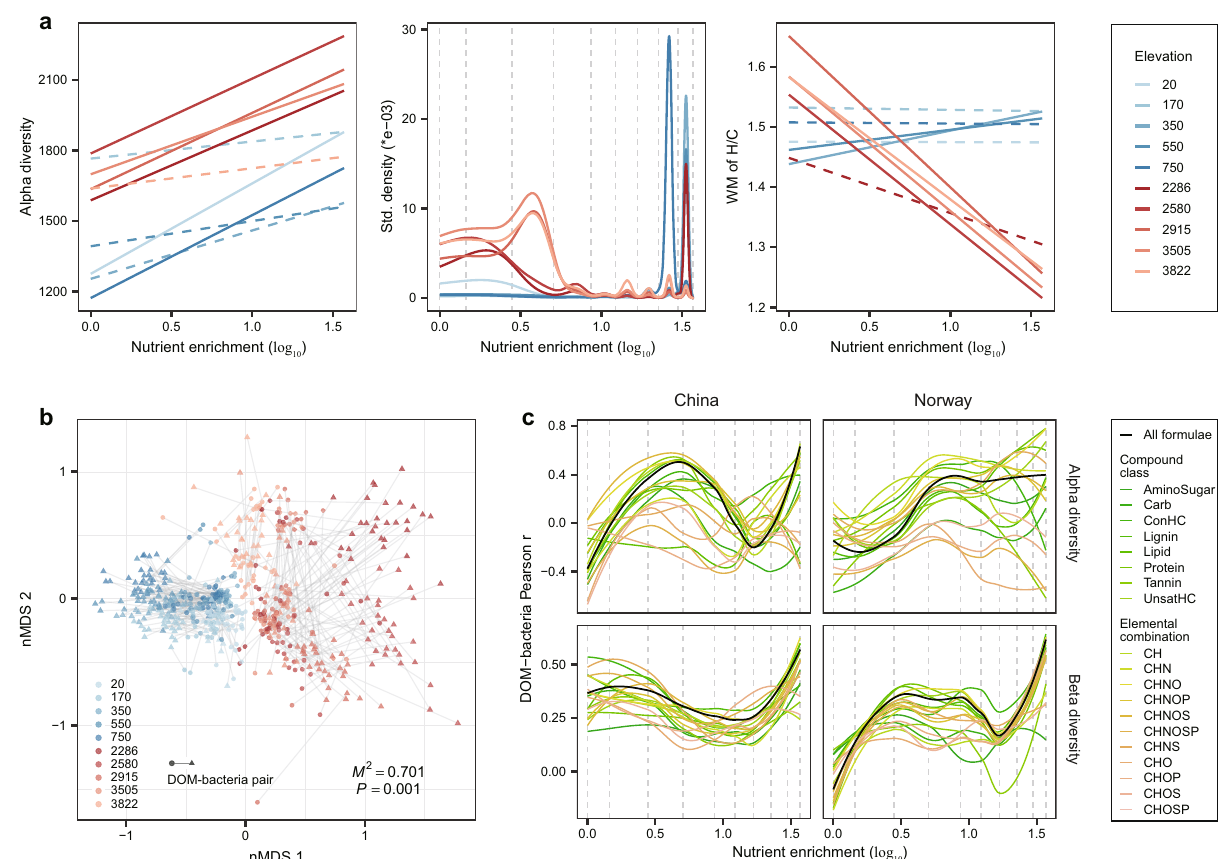
Fig. 3 DOM features and their bacterial associations at a compositional level. a The effects of nutrient enrichment on DOM alpha diversity (richness), composition and molecular traits (e.g., H/C ratio) for all formulae across different elevations in China (red lines, with lower elevations in more red colours) and Norway (blue lines, with higher elevations in more blue colours). We used nitrate addition to represent nutrient enrichment as the ratio between nitrate and phosphorus in the initial overlying water was constant. Molecular richness and weighted mean (WM) of H/C ratio were plotted against the nutrient gradient of nitrate, and their relationships are indicated by solid ( P ≤ 0.05) or dotted ( P > 0.05) lines estimated using linear models with one-sided F-statistics. For better visualization, we did not include the data points in Fig. 3a but showed detailed scatter plots and statistics in Fig. S3. To visualise the DOM compositional changes, we plotted the distribution of breakpoints of each molecule regarding its abundance occurring along the nutrient gradient with gradient forest analysis 30 . b The congruence between DOM and bacterial compositions across different elevations in China and Norway was examined using Procrustes analysis 32,33 . The NMDS plots the position of DOM and bacterial assemblages that have been optimized based on Procrustes analysis. Each line with circle and triangle ends connects to a single community of DOM and bacteria, respectively, and is coloured by elevation in either China (red) or Norway (blue). The fi t of overall Procrustes transformation is reported as the M 2 value, and the signi fi cance was examined using a permutation-based approach with 999 permutations and the two-sided statistically signi fi cant P value is shown. c The effects of nutrient enrichment on DOM-bacteria associations. The associations were quanti fi ed by the Pearson correlation coef fi cient r between alpha diversity of DOM and bacteria (upper panel), and by the Mantel correlation r between the beta diversity of DOM and bacteria (lower panel). We then visualised correlation r values with loess regression models along the nutrient gradient, and these correlations at each nutrient level are shown in Fig. S8. The colours of the lines indicate the DOM composition for all formulae and categories of compound classes or elemental temperatures in China (Fig. S7). In Norway, the differences were always lower, on average, and did not vary with temperature (Fig. S7). Nutrient enrichment in fl uenced the correlations between the number ( “ alpha diversity ” ) of DOM molecules and bacterial operational taxonomic units (OTUs) in each microcosm, or between the similarity in composition ( “ beta diversity ” ) of DOM and bacterial communities for all pairwise combinations of microcosms within a region (Fig. 3c). These results were consistent for individual compound classes or elemental combi- nations (Fig. 3c). Interestingly, the coordinated compositional changes in DOM and bacteria, measured by the Mantel correlation 34 between their beta diversities among pairwise microcosms, increased more strongly with nutrient enrichment in Norway than in China, especially at low nutrient levels beneath 1.80 mg N L − 1 (Figs. 3c, S8).